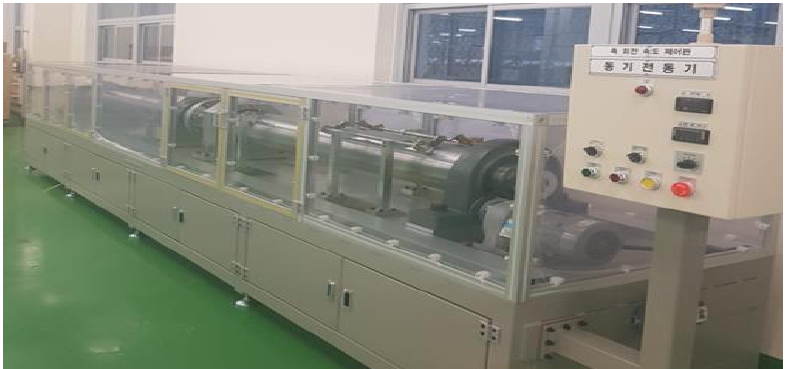
Figure 5. Photo of the experimental setup for electrical pitting prevention device.